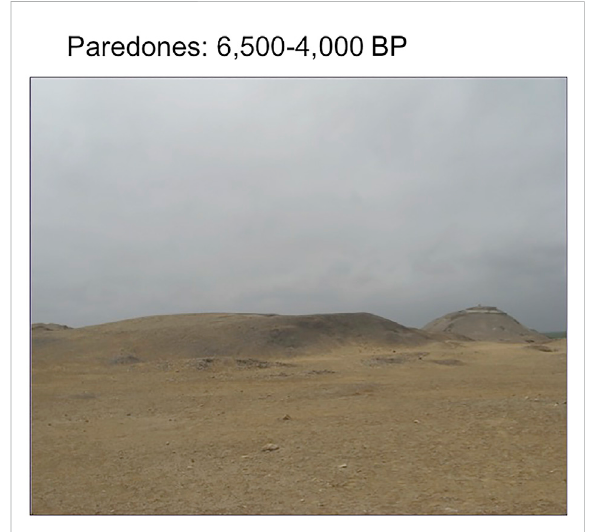
The Paredones mound in the foreground located about 600 m north of Huaca Prieta. In the background is a large Moche pyramid dated from ~1,500 to 1,200 years